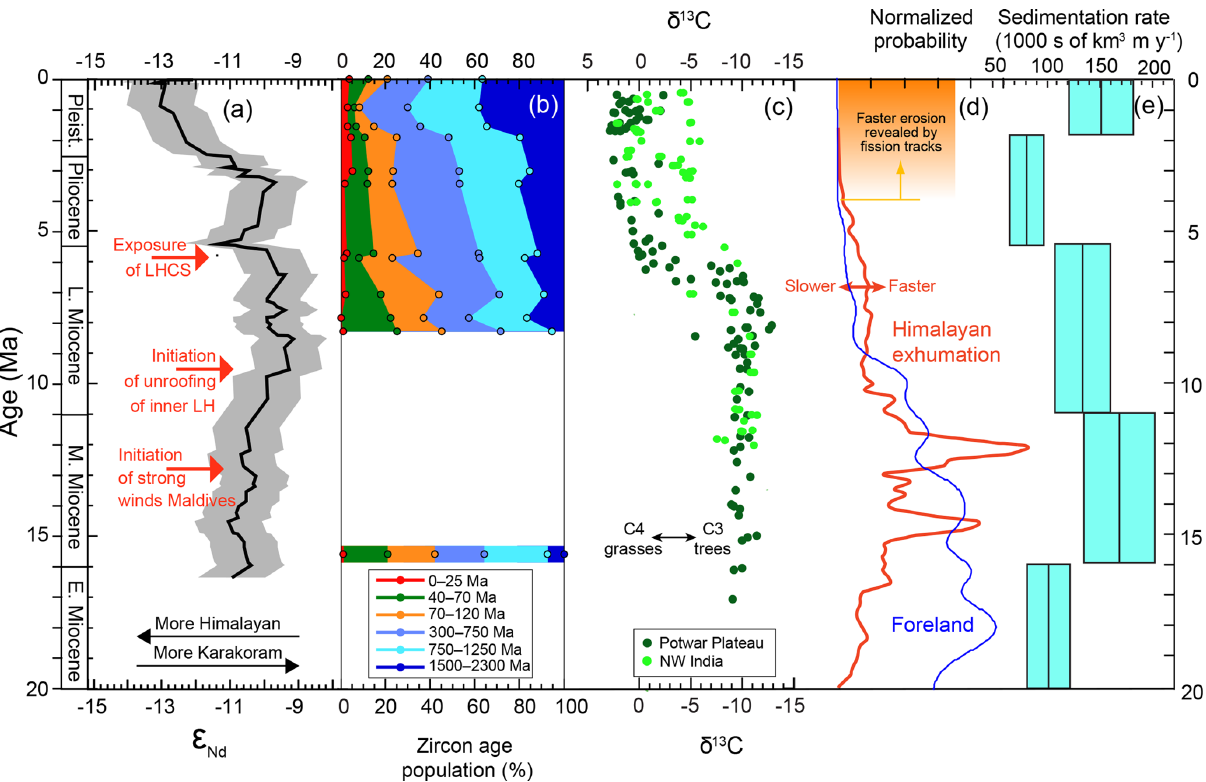
Figure 8. Comparison of climate, erosion, and exhumation proxies in the Himalaya. (a) Smooth Nd isotope history for the Indus River from the Arabian Sea with grey background showing effective uncertainties from Fig. 5. (b) Breakdown of detrital zircon U–Pb age populations with each source diagnostic group shown as its proportion of the total. Percentage is recalculated to exclude nondiagnostic aged grains. (c) Carbon isotope character of pedogenic carbonate in Pakistan as an indicator of dominant vegetation in the Potwar Plateau of Pakistan (Quade et al., 1989) and NW India (Singh et al., 2011). (d) Relative exhumation rates of the Greater Himalaya tracked by bedrock Ar–Ar dating (Clift et al., 2008) and zircon fission track from foreland basin sediment (Chirouze et al., 2015). (e) Rates of sediment supply to the Arabian Sea calculated from regional seismic reflection surveys (Clift, 2006). KK: Karakoram; LH: Lesser Himalaya; LHCS: Lesser Himalayan crystalline